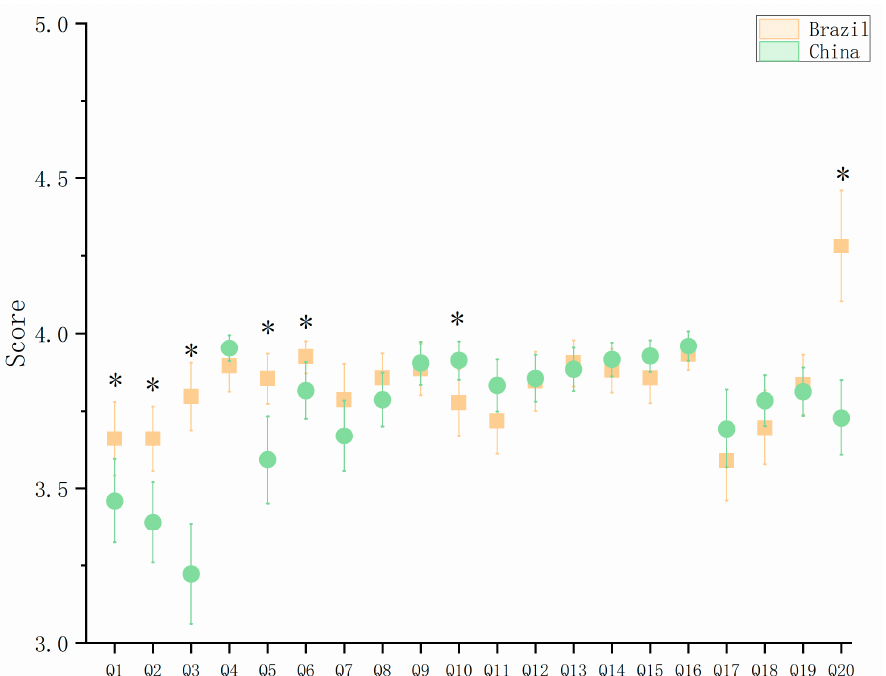
Figure 1. Quality-of-vision scores obtained with the questionnaire (* means significant difference was found between the two groups).